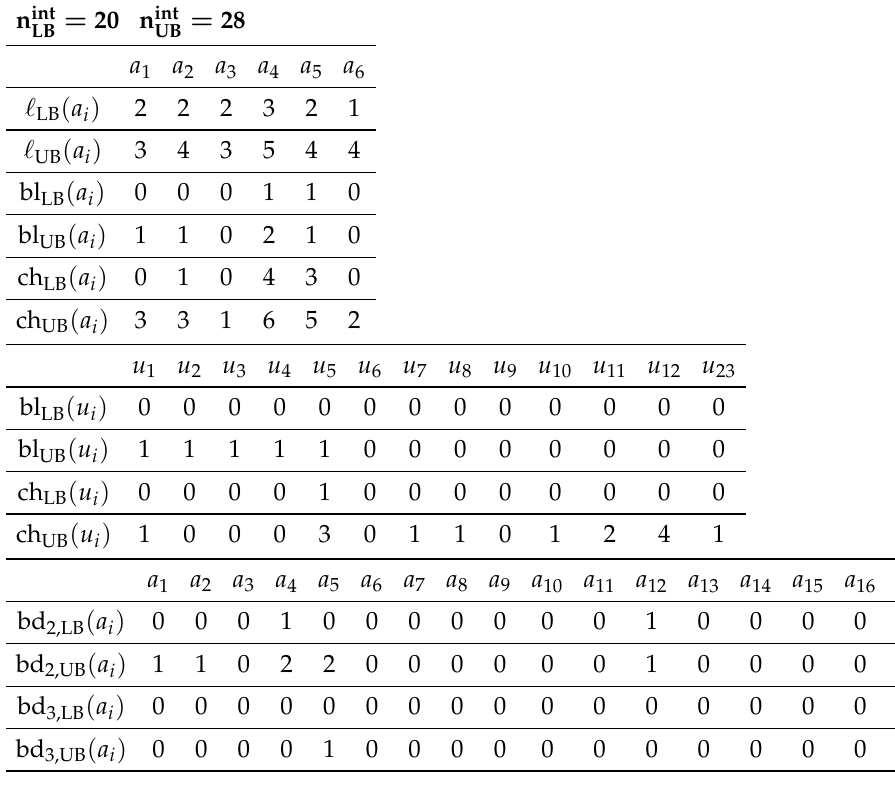
Table 1. Example 1 of an interior-specification σ int